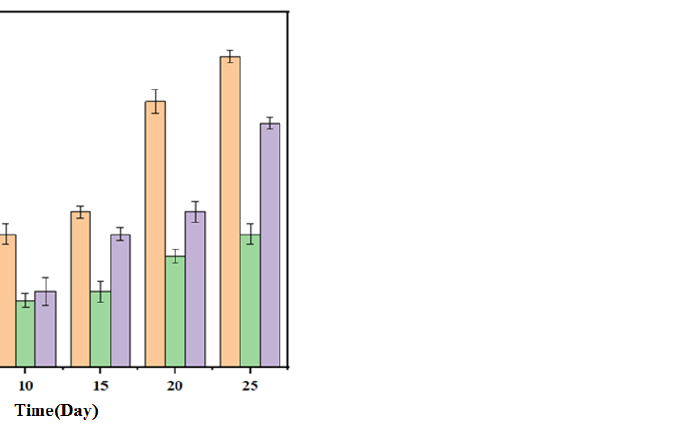
Figure 4. Changes in microbial metabolite concentration and conductivity in OsMFC anolyte with operation time.